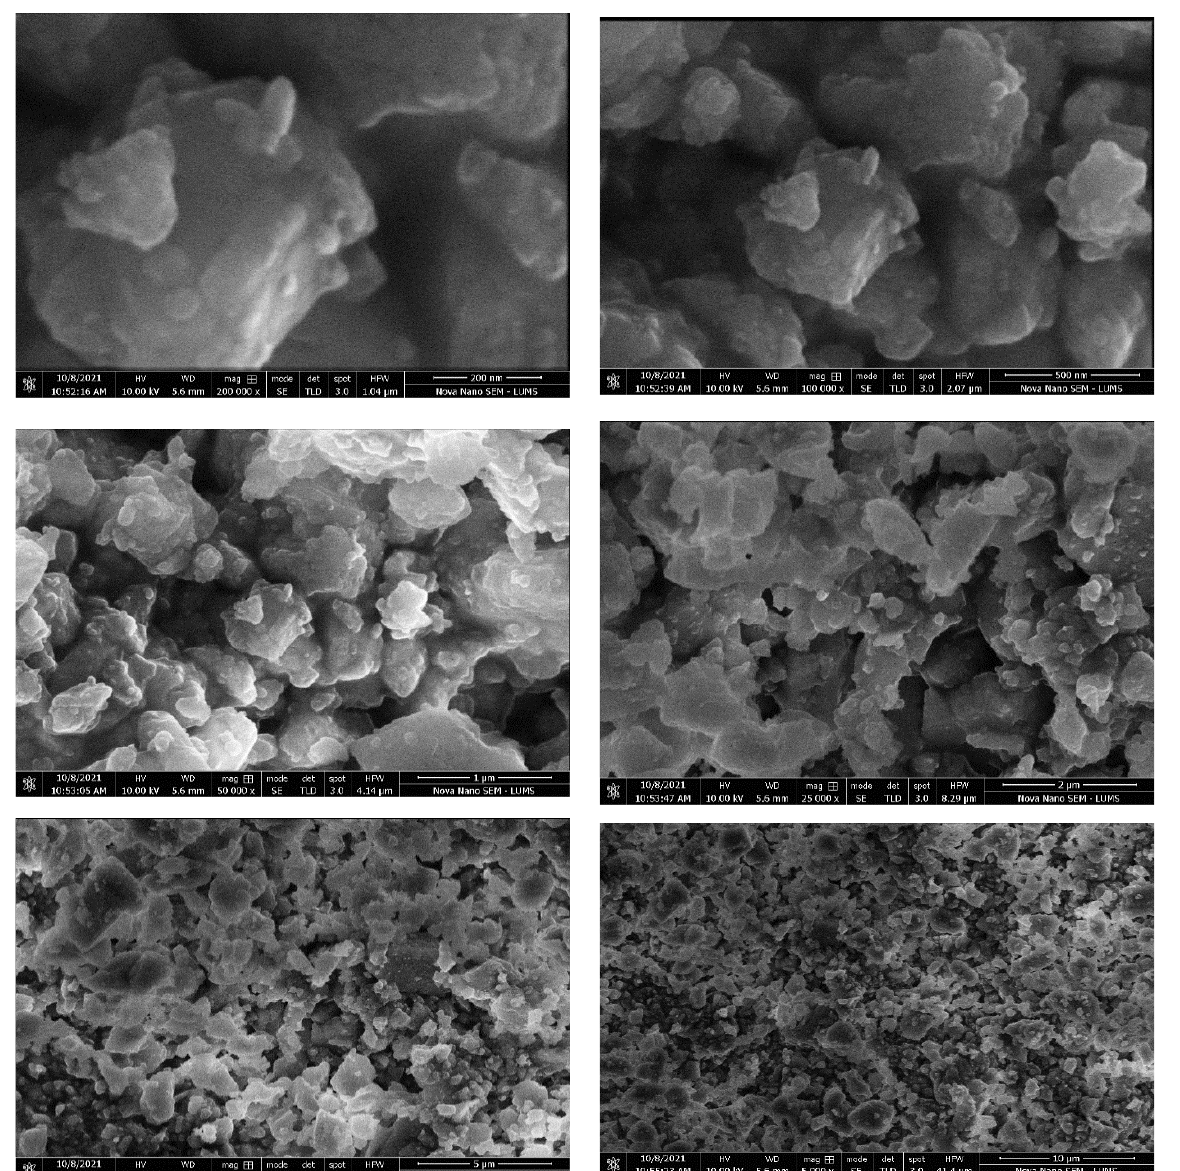
Figure 7. SEM analysis of hoshanar marble waste treated with mixture of potassium ferricyanide and sodium metasilicate.